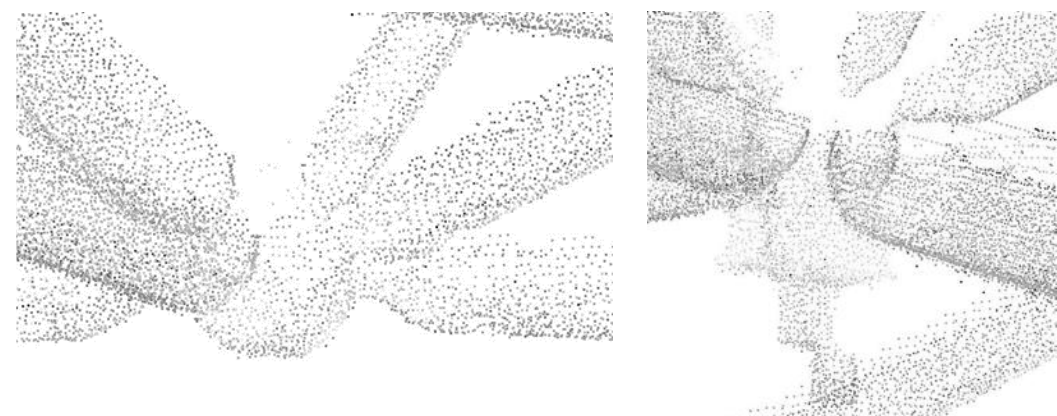
Figure 20. Spherical and cylindrical nodes of the TLS point cloud.